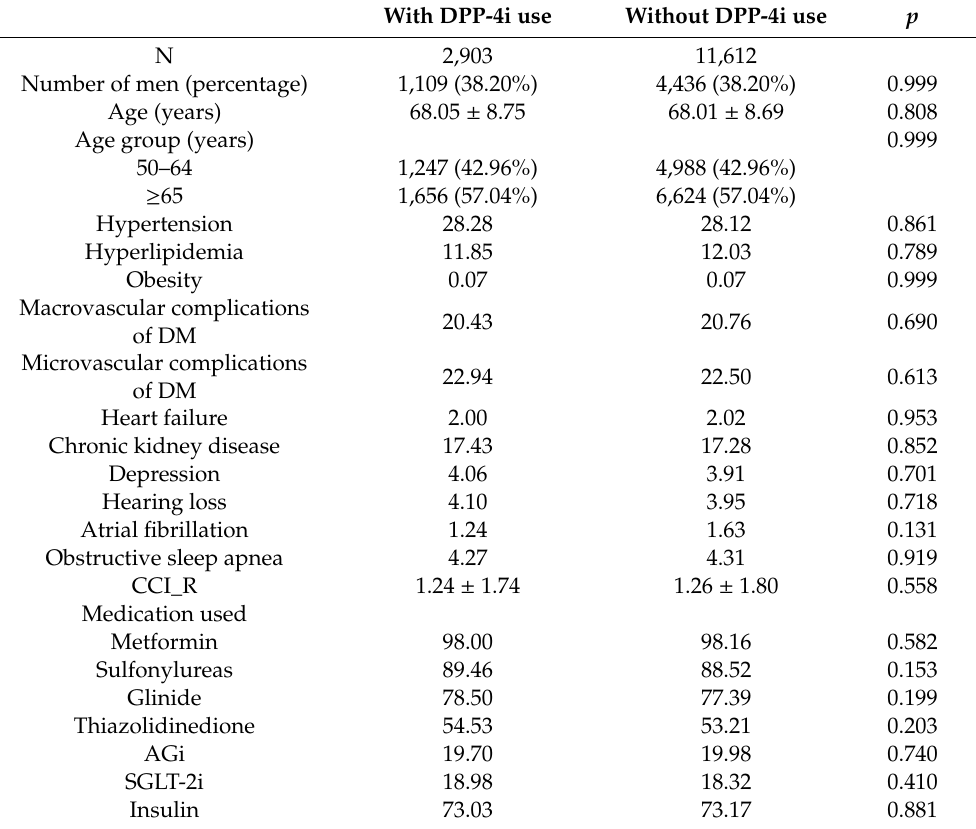
Table 1. Baseline characteristics of the matched pairs.